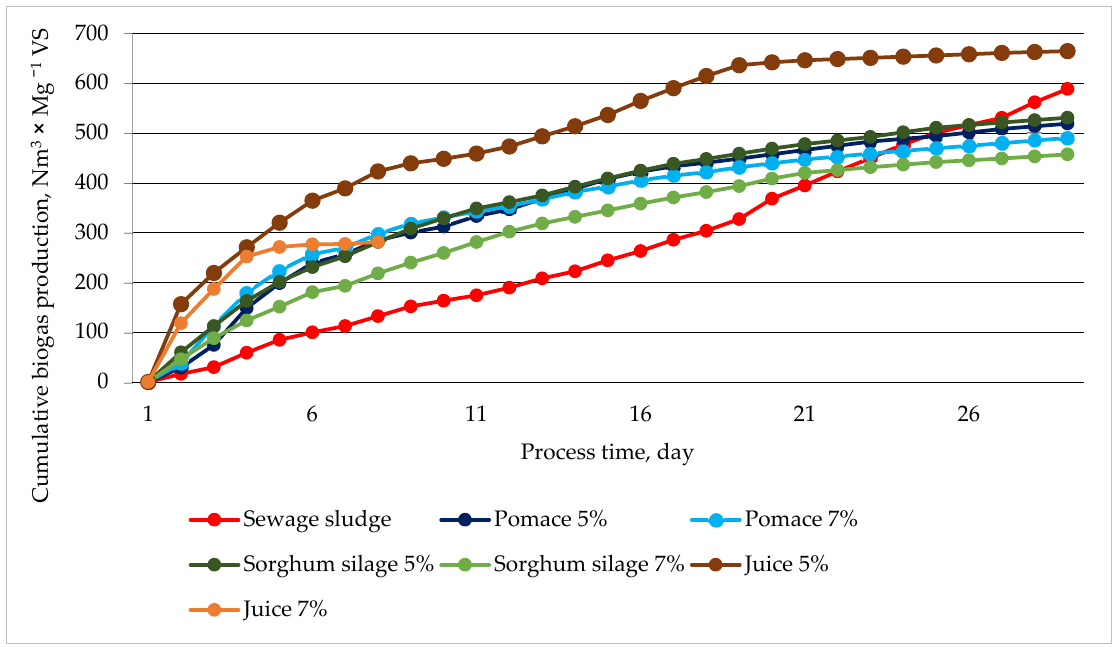
Figure 2. Cumulative biogas production from sewage sludge and substrates from sorghum (detailed values are included in Supplementary Material Table S1).